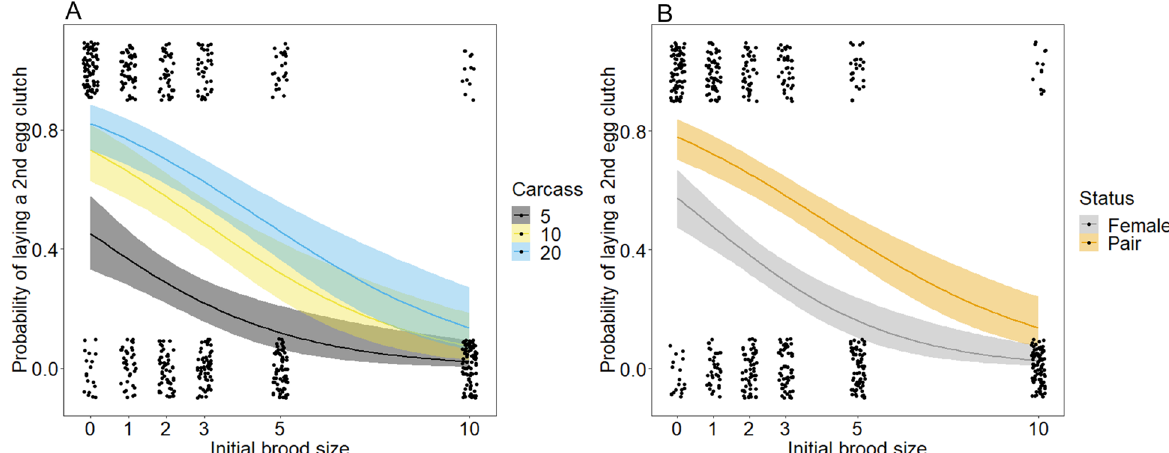
Figure 1. Relationship between the probability of N. vespilloides females to lay a second egg clutch and initial brood size ( A ) on three different carcass sizes and ( B ) when breeding with a male partner or alone. The dots represent the original data, the lines represent the calculated regression lines and their respective 95%